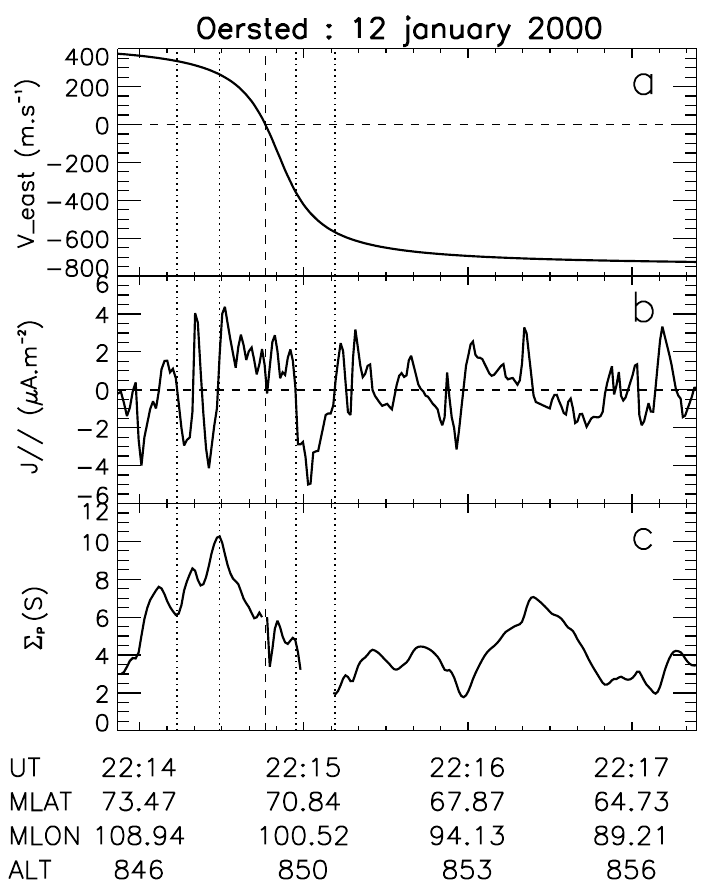
Fig. 9. Inputs (a and b) and result (c) parameters of the 1-D simulation along the Ørsted orbit. (a) East-west con- vection profile deduced from the Su- perDARN convection map. (b) Field- aligned current measured by Ørsted. (c) Modelled ionospheric Pedersen con- ductance. Dotted lines delineate the three parallel current sheets and the dashed line indicates the velocity